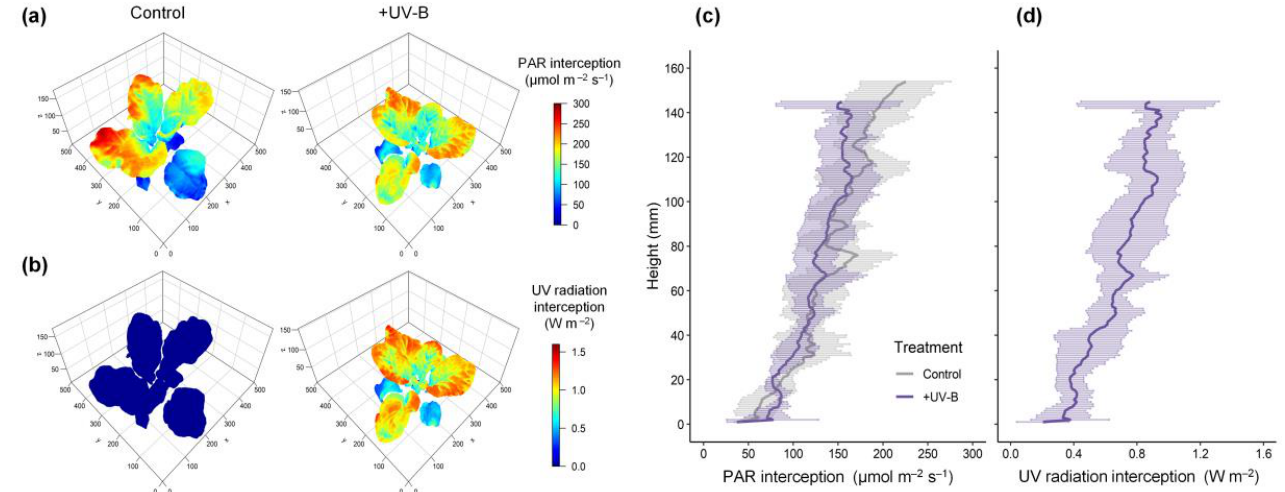
Figure 1. Representative simulated PAR and UV radiation interceptions ( a , b ) and vertical distributions ( c , d ) on the kales in the control and UV-B treatments. PAR, photosynthetically active radiation in the range of 400–700 nm ( a , c ); UV, biological effective UV radiation in the range of 280–400 nm ( b , d ). The three axes (x, y, z) represent the actual size in mm. The centerline and area are represented as the mean ± SD ( n = 3) at each height of the plant model.